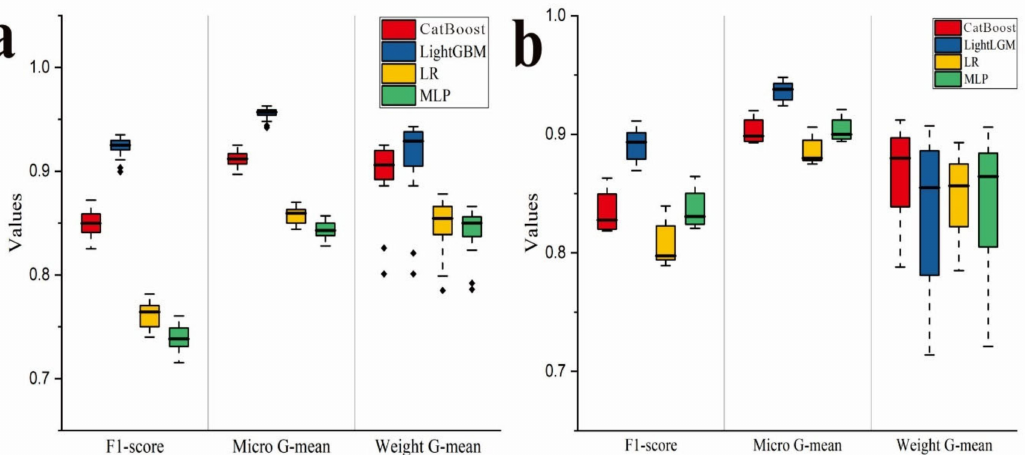
Figure 14. Boxplot diagram of the prediction results of the used models in cases A ( a ) and B ( b